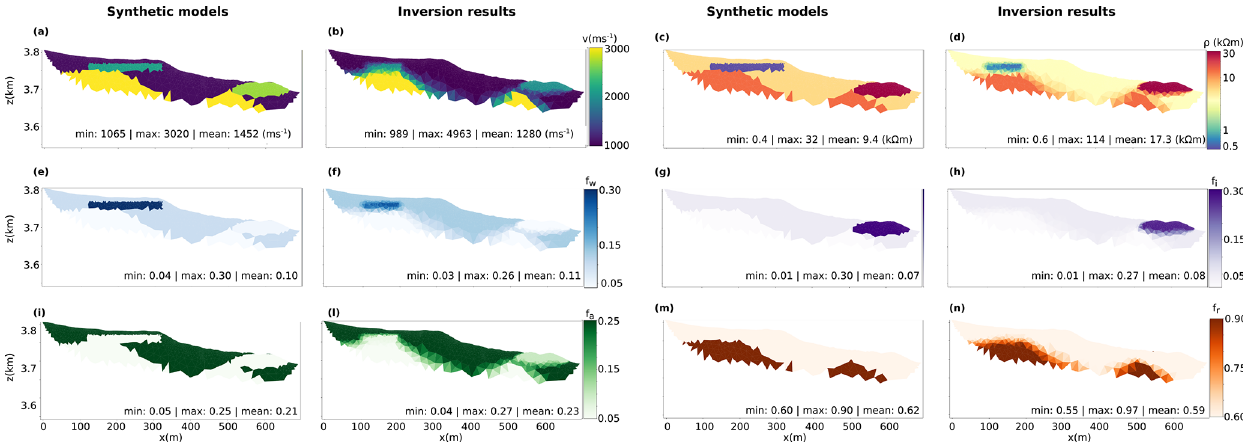
Figure A1. Synthetic models and results of petrophysical joint inversion for the El Jote field data settings. (a, b) Velocity- and (c, d) resistivity-transformed models. The directly modelled and inverted parameters are (e, f) water, (g, h) ice, (i, l) air and (m, n) rock volumetric content. All models are cut off below the lowermost ray path, with only the resistivity colour bar expressed in logarithmic scale.